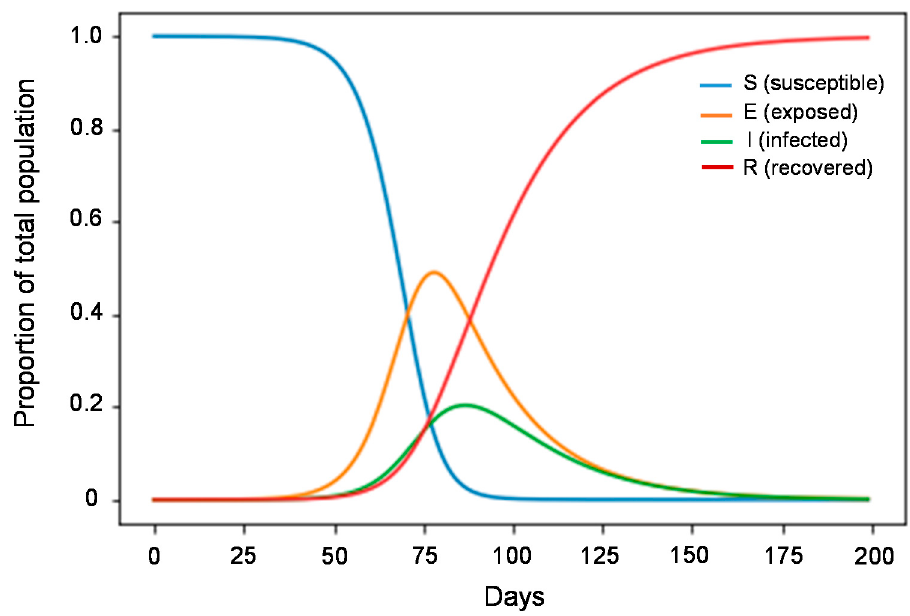
Figure 3. SEIR model to predict disease spread. S is the number of susceptible individuals, E is the number of exposed individuals, I is the number of infected individuals, and R is the number of recovered individuals. This model was generated using a Python script [123].